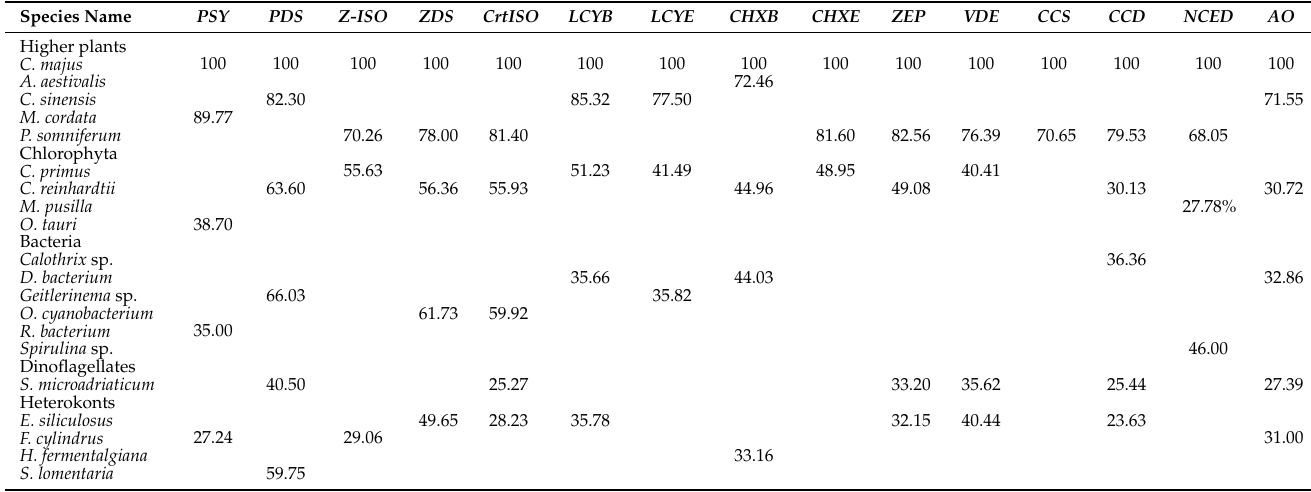
Table 2. Percentage identity (%) analysis of amino acid sequences, comparing between C. majus CBP, XBP, and ABP genes and other CBP, XBP, and ABP amino acid sequences. Accession numbers of the sequences are provided in Figure S2 and Table S3. Species Name Higher plants C.